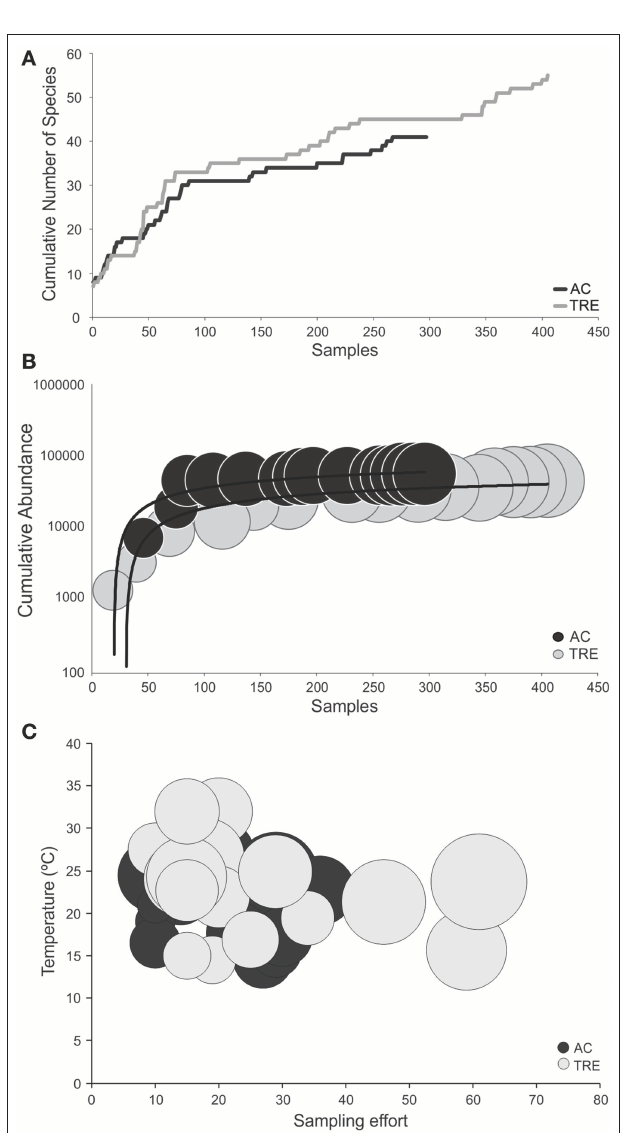
FIGURE 3 | (A) Cumulative curve of number of species per sample; (B) cumulative curve of number of individuals collected ( y -axis) per samples ( x -axis) and the relationship with number of species (circle size is proportional to species richness); and (C) the relationship between the variables predicted by the gamma model (effort and temperature) and species richness (circle size is proportional to species richness), separated by environment. TRE, Tramandaí River estuary; AC, marine adjacent coastal